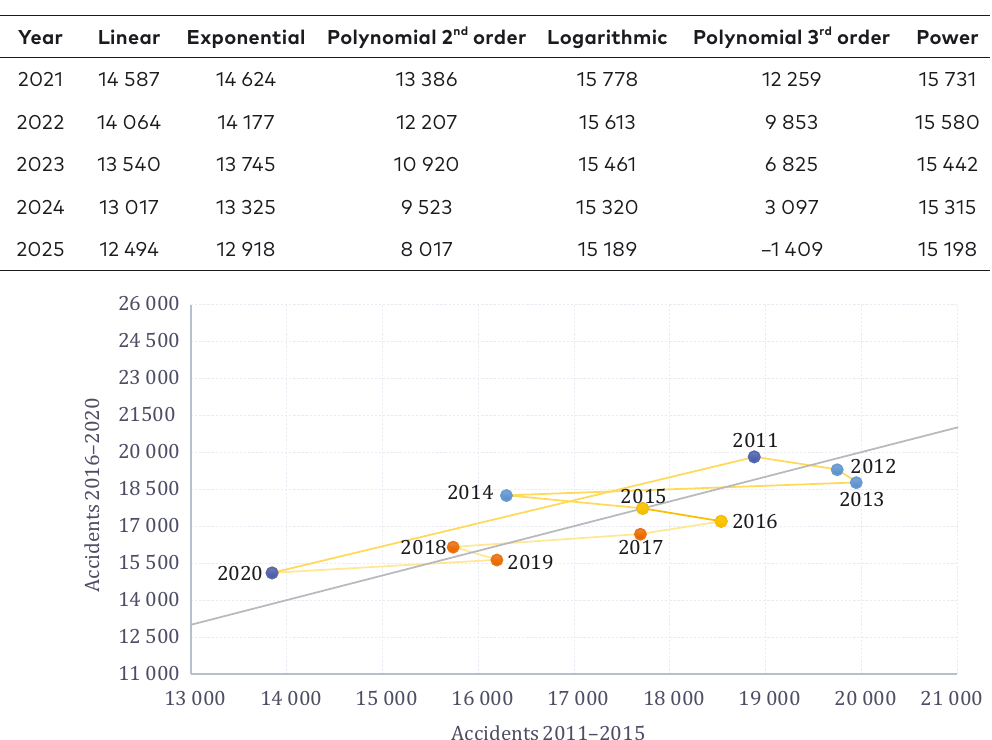
Table 3. The total number of predicted traffic accidents in Kosovo for the period from 2021 to